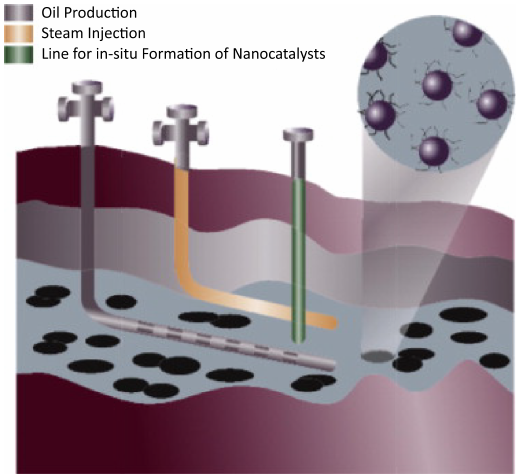
Figure 30. Schematic representation of in-situ heavy oil recovery and upgrading, coupling ultradispersed nanocatalyst and the steam-assisted gravity drainage (SAGD) process. Light oil is then produced at the surface and the heavy molecules, solids, and minerals remain underground. Figure reproduced from Refs. [35,103].